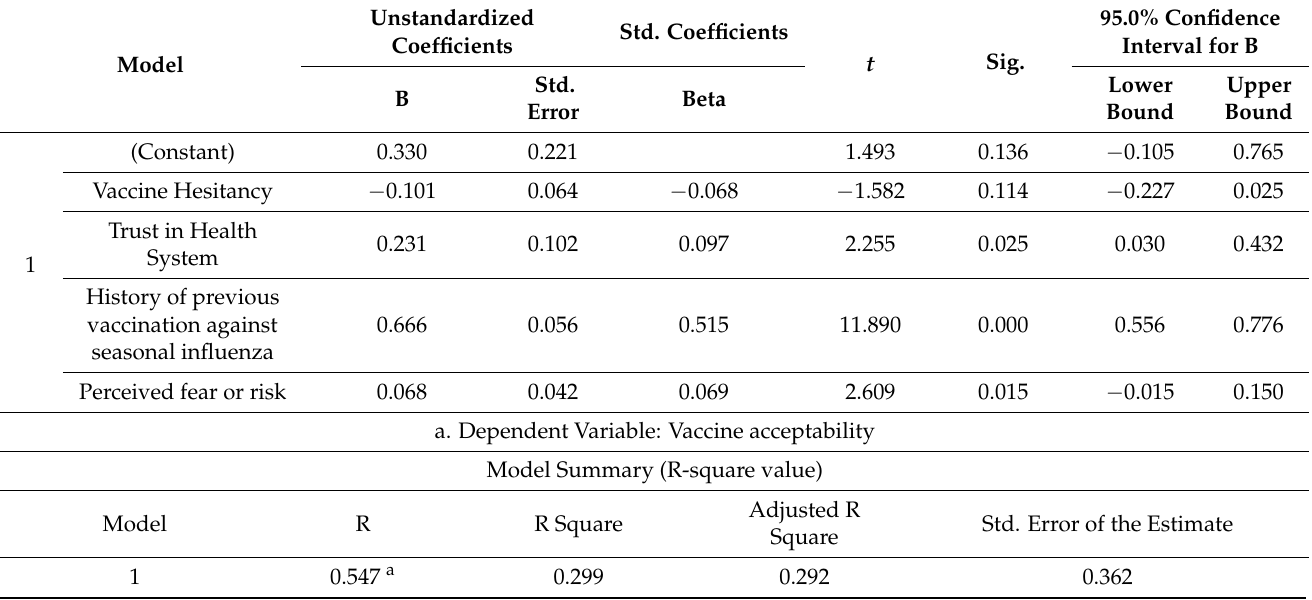
Table 5. Path coefficients results through regression